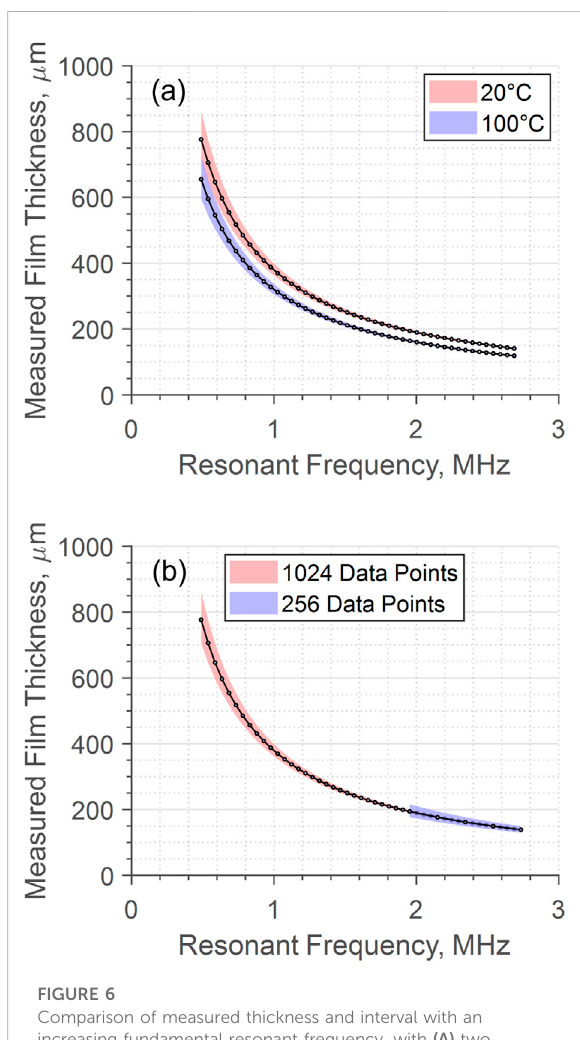
FIGURE 6 Comparison of measured thickness and interval with